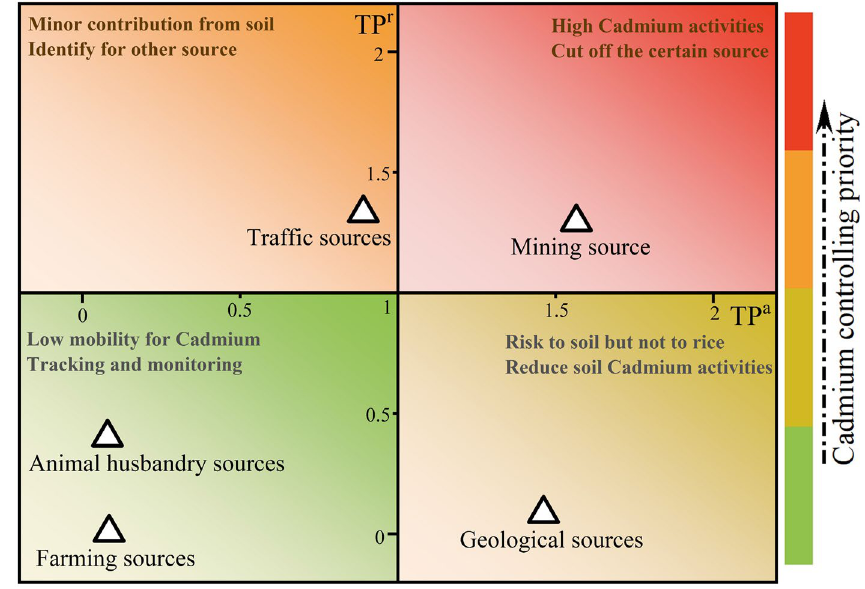
Figure 6. The priority of different sources on cadmium control.